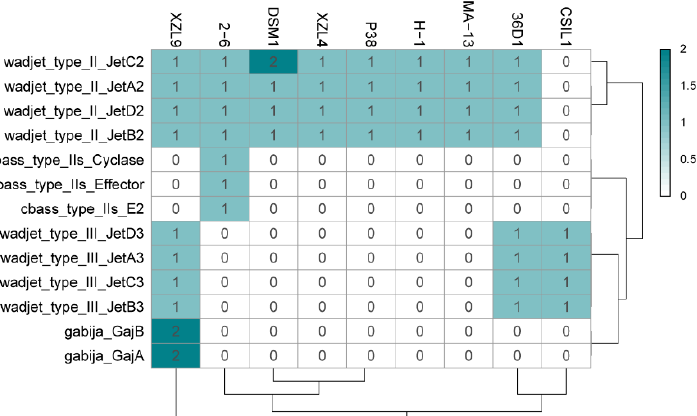
Figure 7. Heat map distribution of innate immunity systems in the W. coagulans strains. Green and white represent the highest and lowest number of proteins.